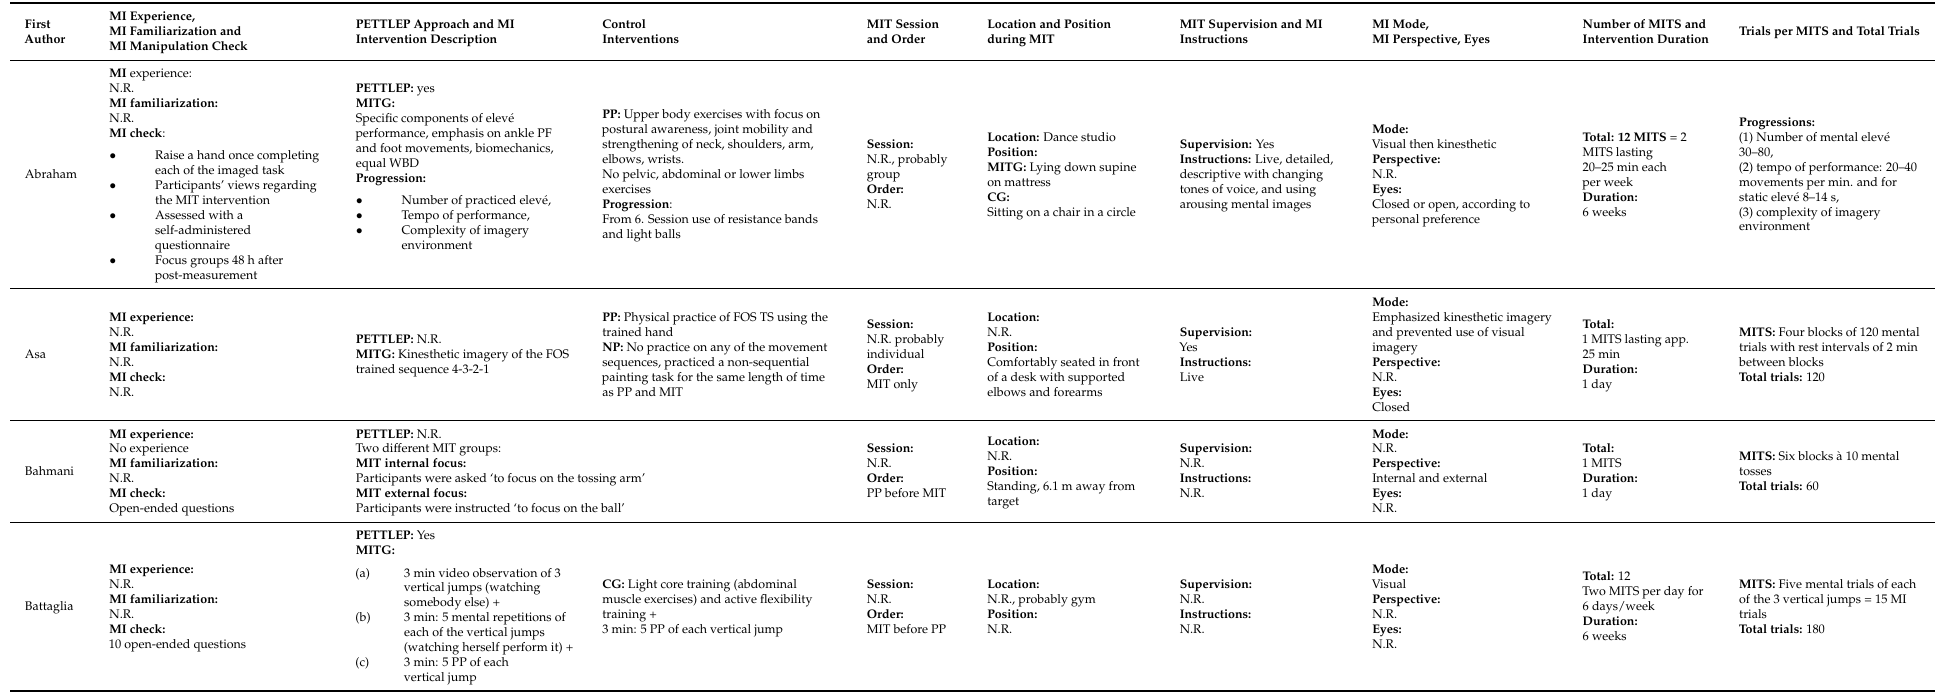
Table 3. Motor imagery training interventions of included